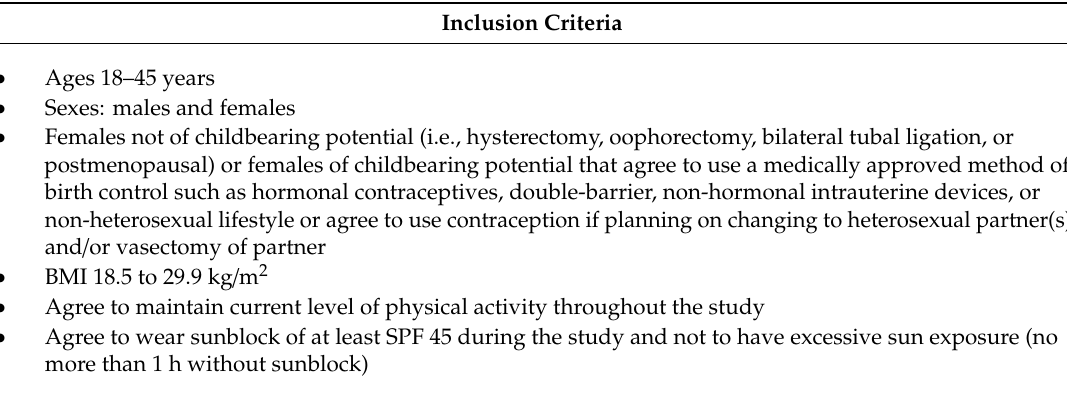
Table 1. Inclusion and exclusion